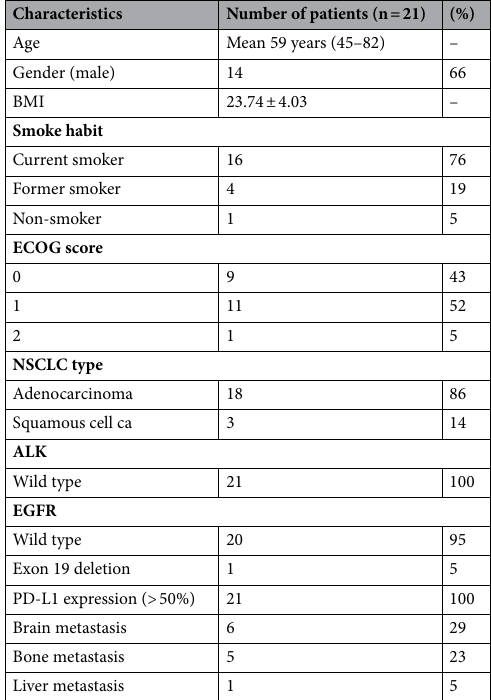
Table 1. Demographic and clinical patients’ characteristics, tumor